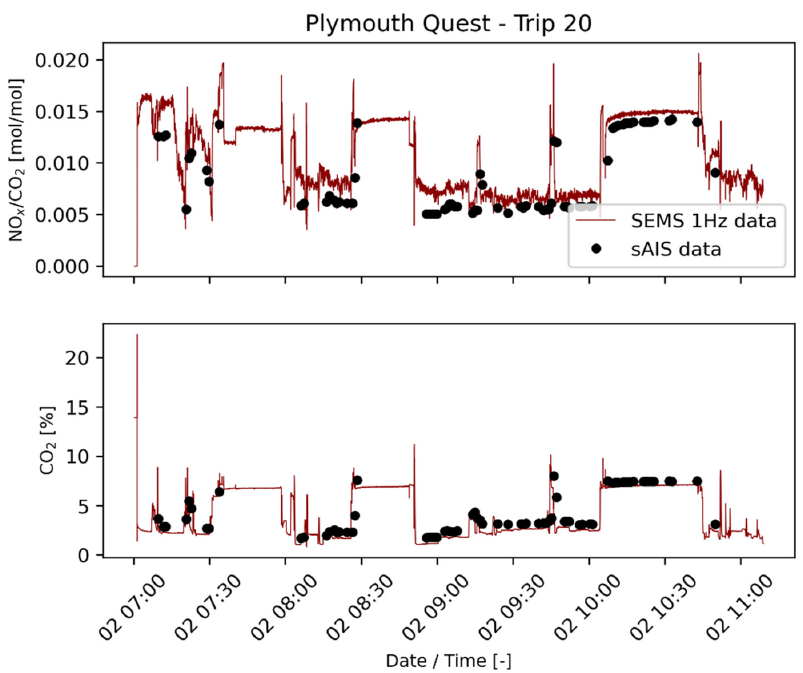
Figure 10. Comparison of SEMS 1 Hz data and S-AIS data on RV Plymouth Quest (Trip 20).